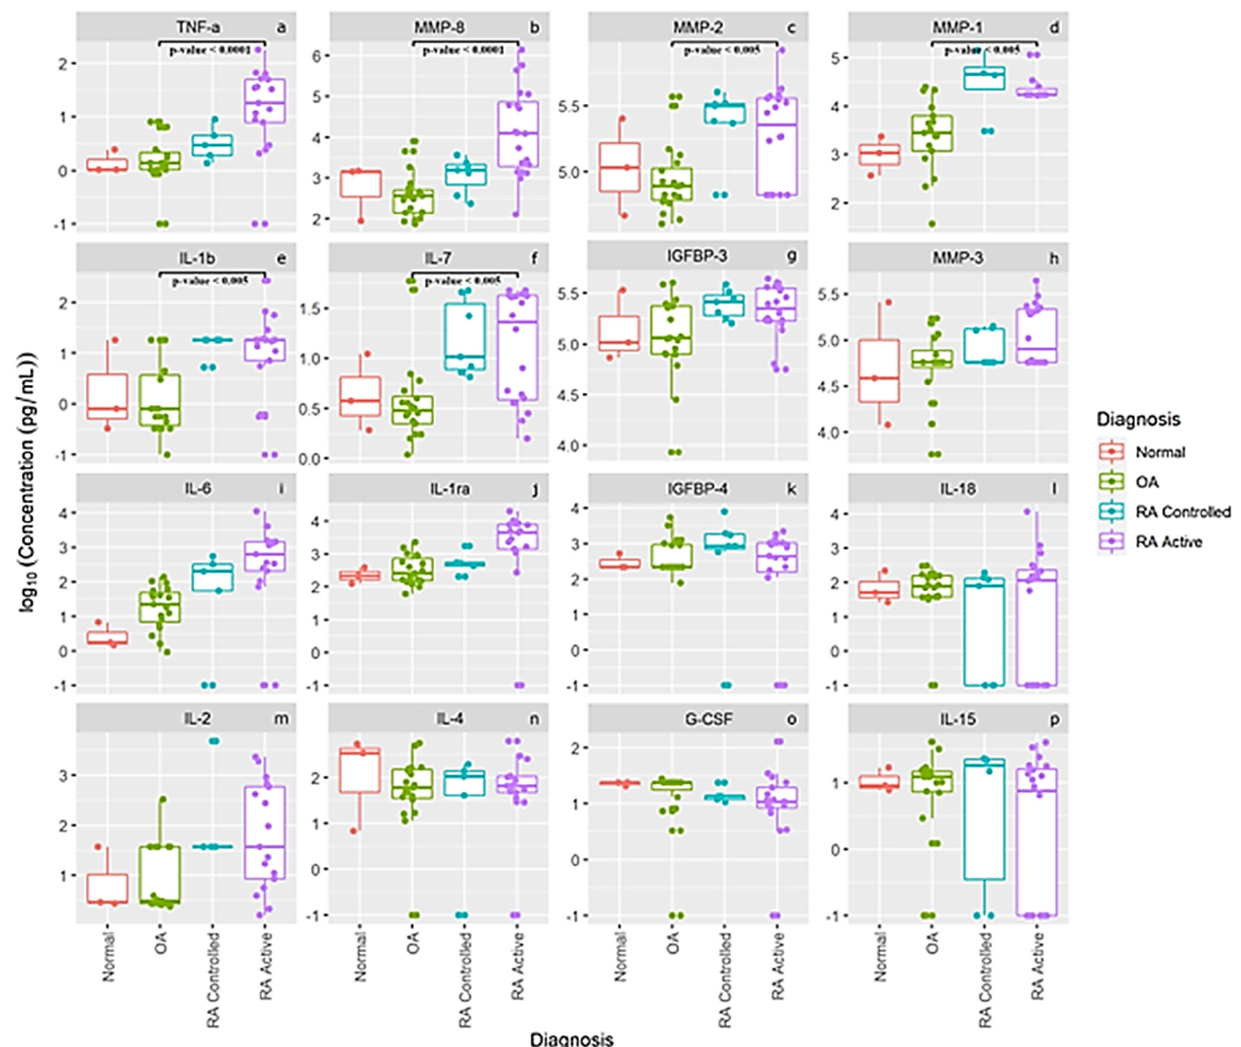
Figure 2. Synovial fluid log concentration levels of cytokines, chemokines, MMPs and select protein levels from normal subjects, patients with OA, and patients with controlled rheumatoid arthritis and active rheumatoid arthritis. Panel legend: panel ( a ) TNF- α = Tumor Necrosis Factor alpha, panel ( b ) MMP-8 = Matrix Metalloproteinase 8, panel ( c ) MMP-2 = Matrix Metalloproteinase 2, panel ( d ) MMP-1 = Matrix Metalloproteinase 1, panel ( e ) IL-1 b = Interleukin 1 beta, panel ( f ) IL-7 = Interleukin 7, panel ( g ) IGFBP-3 = Insulin-Like Growth Factor-Binding Protein 3, panel ( h ) MMP-3 = Matrix Metalloproteinase 3, panel ( i ) IL-6 = Interleukin 6, panel ( j ) L-1 ra = Interleukin 1 receptor antagonist, panel ( k ) IGFBP-4 = Insulin-Like Growth Factor-Binding Protein 4, panel ( l ) IL 18 = Interleukin 18, panel ( m ) IL-2 = Interleukin 2, panel ( n ) IL-4 = Interleukin 4, panel ( o ) G-CSF = Granulocyte Colony Stimulating Factor, and panel ( p ) IL-15 = Interleukin 15.